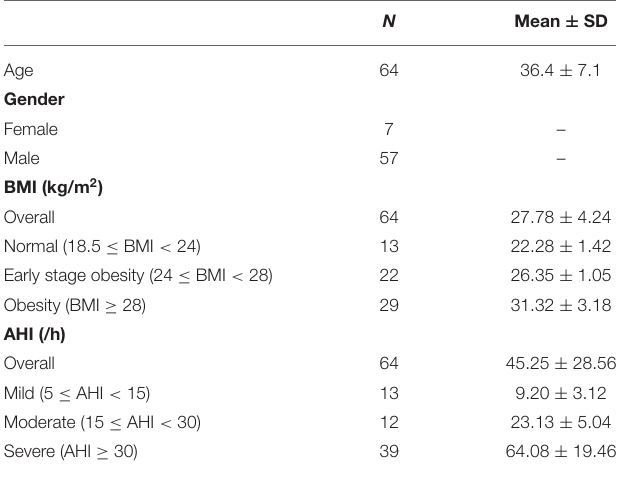
TABLE 1 | Demographic information and clinical characteristics of the OSA